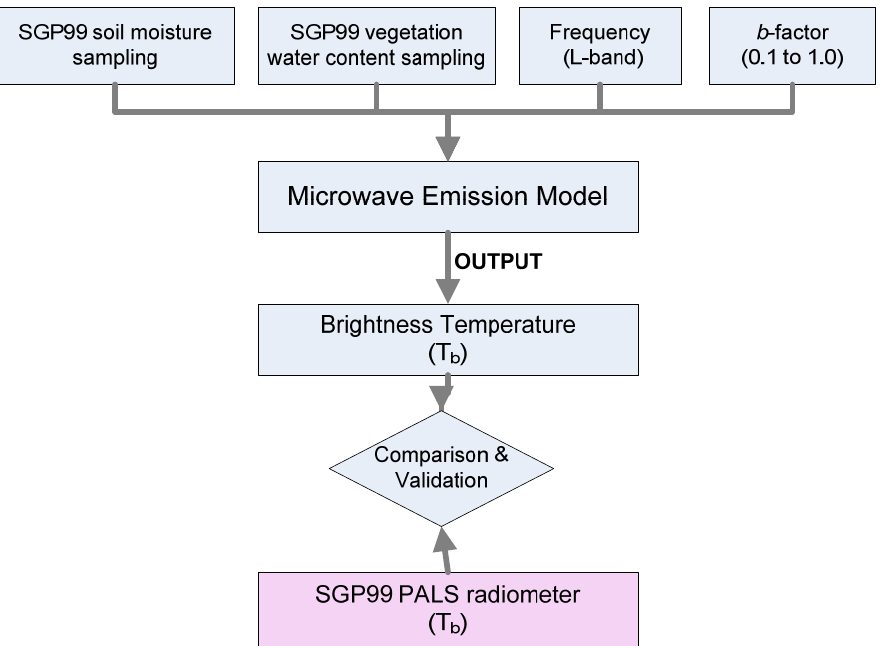
Figure 4. Flowchart of the validation of brightness temperature using the microwave emission